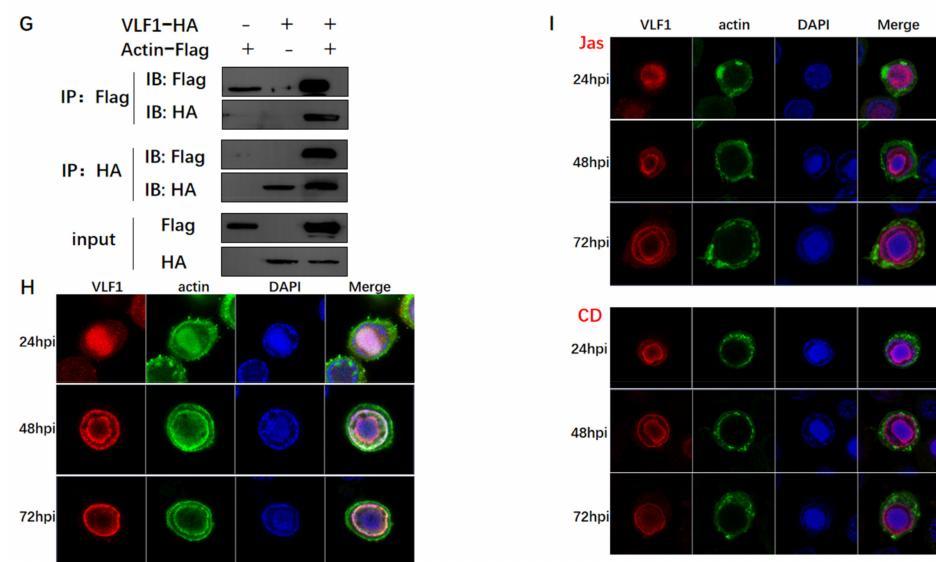
Figure 5. The analysis of the relationship between actin and transcriptional regulators. ( A , D , G ) Co-IP assays used to confirm interactions of actin with PK1 and IE1. The method was the same as in Figure 3. ( B , E , H ) Co-localization analysis of actin with PK1 and IE1 by confocal microscopy. The method was the same as in Figure 3. ( C , F , I ) As in ( B , E , H ), at 15 h p.i., cells were treated with Jas or CD and then subjected to confocal